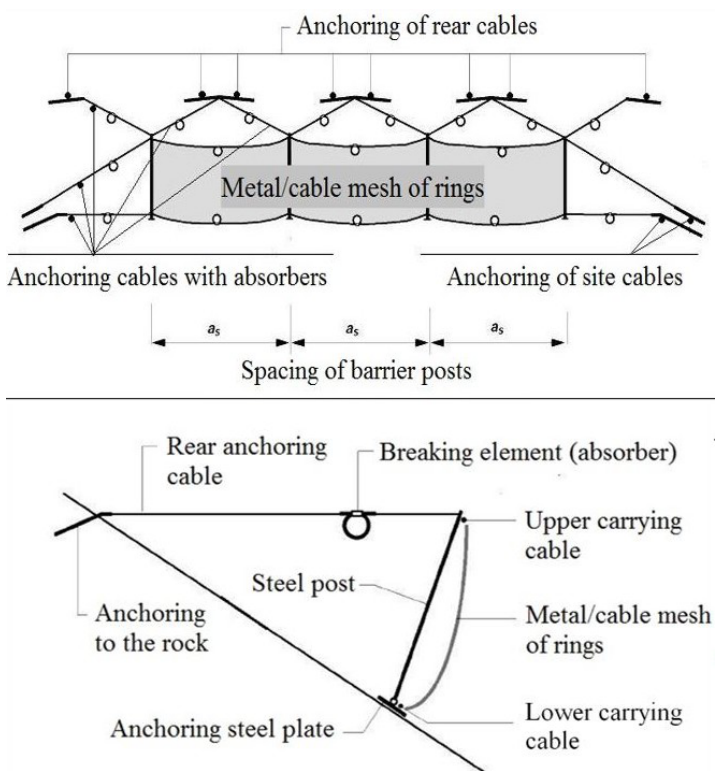
Figure 6. Dynamic barrier – schematic view and cross section.